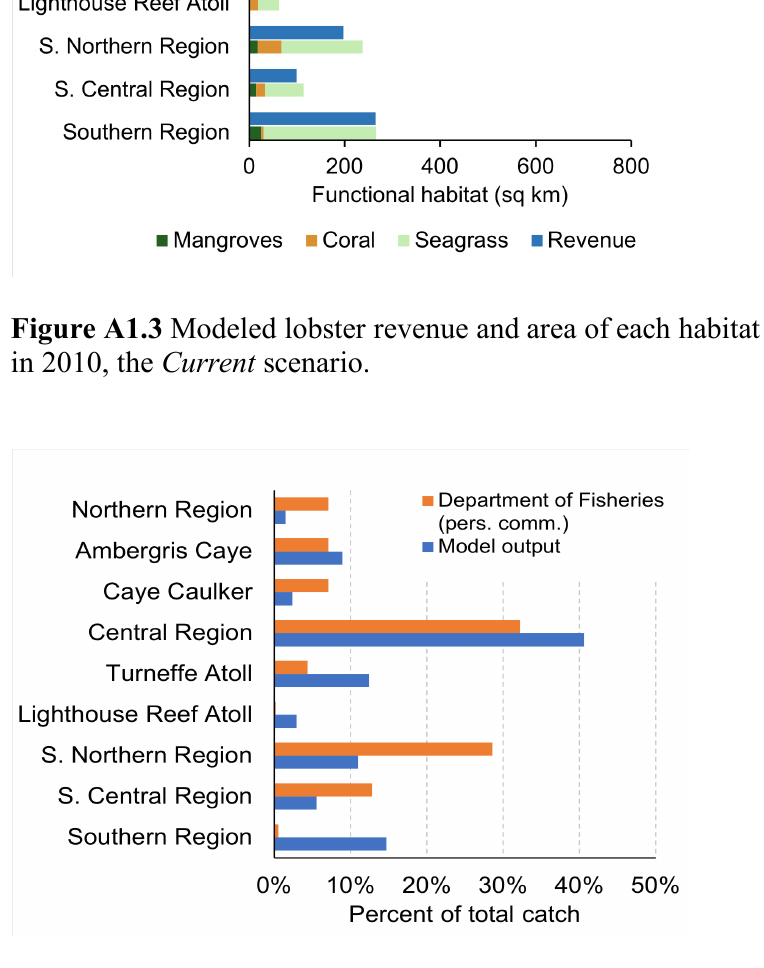
Figure A1.4 Qualitative comparison between empirical information on spatial variation in catch from the Belize Fisheries Department and modeled catch by planning region for the Current